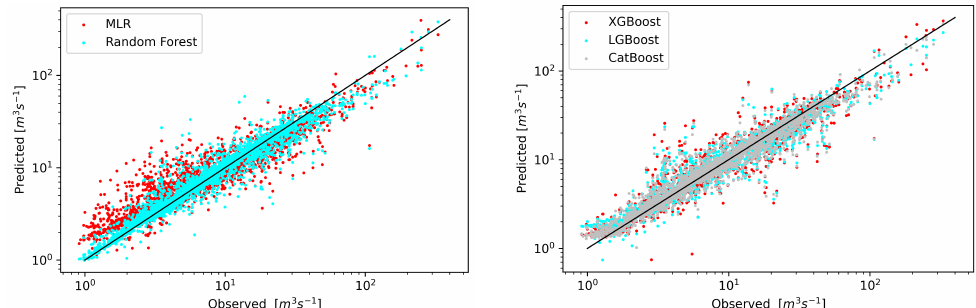
Figure 3. Scatterplot of observed and predicted streamflow with default model parameters for all data scenario (precipitation, upstream and lag